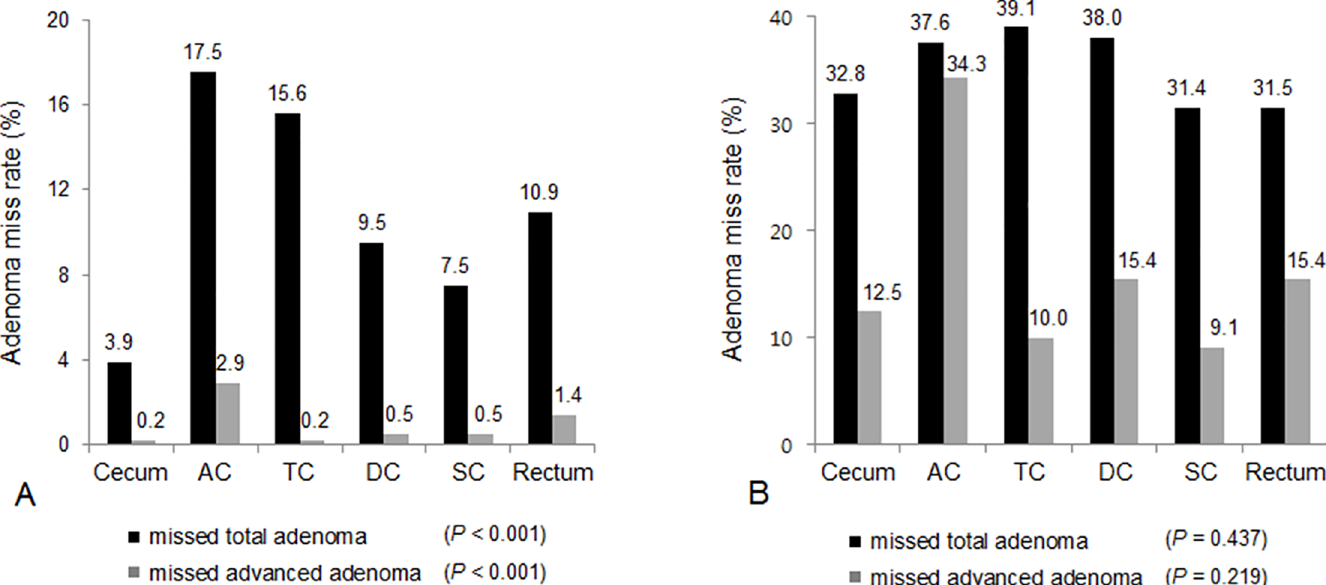
Fig 1. Adenoma miss rates (AMR) according to colonic location. Per-patient AMR according to colonic segment (Fig 1A). Proportion of missed total and missed advanced adenomas was significantly different according to location ( P < 0.001). Per-adenoma AMR according to colonic segment (Fig 1B). There was no significant difference in proportion of missed total adenoma ( P = 0.437). The AMR for advanced adenoma was 34.3% at ascending colon, twice as high as the AMR in other segments, but this difference was not statistically significant ( P = 0.219). AC, ascending colon; TC, transverse colon; DC, descending colon; SC, sigmoid colon.